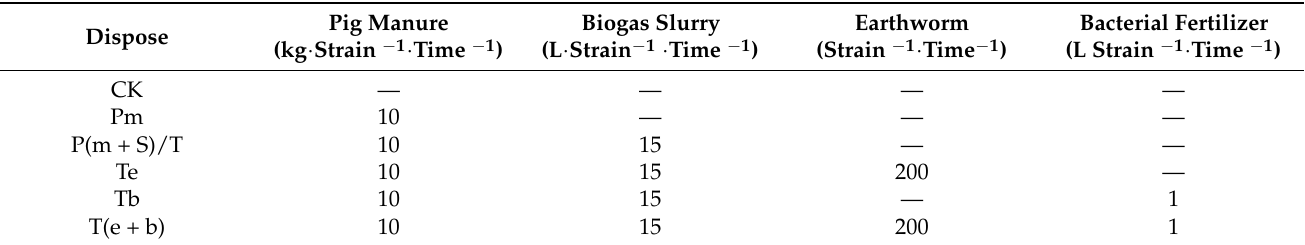
Table 2. Design of